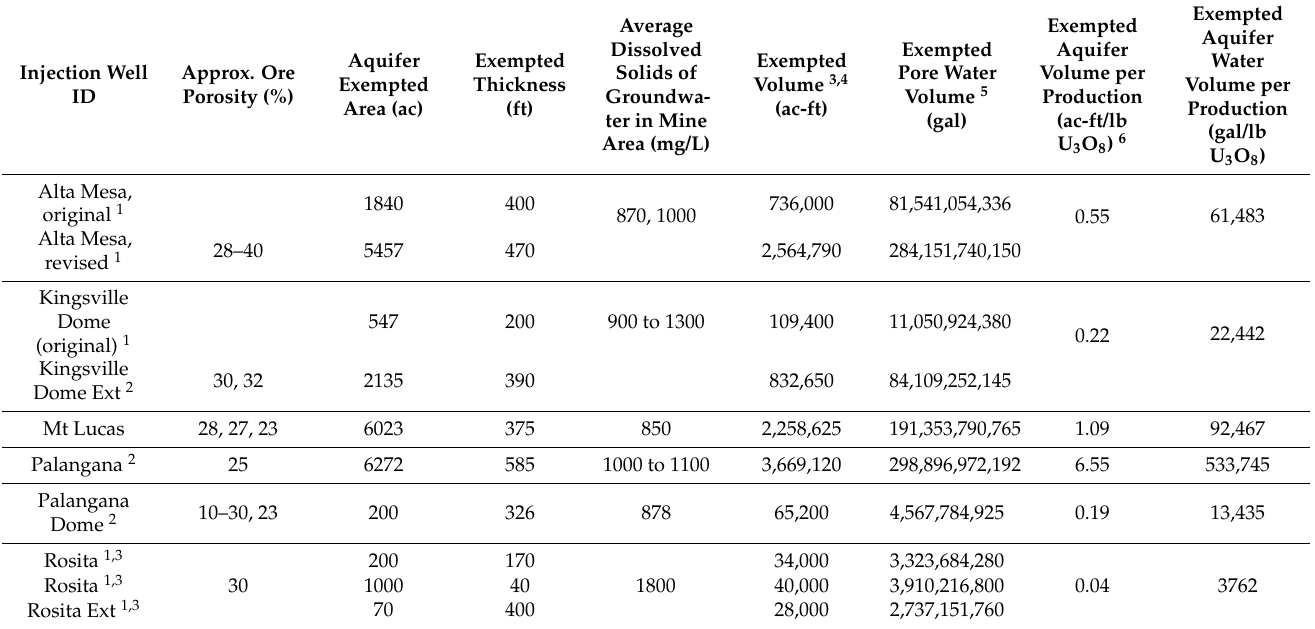
Table A3. Quantities of aquifer exemptions for the Goliad Sand ISR operations.